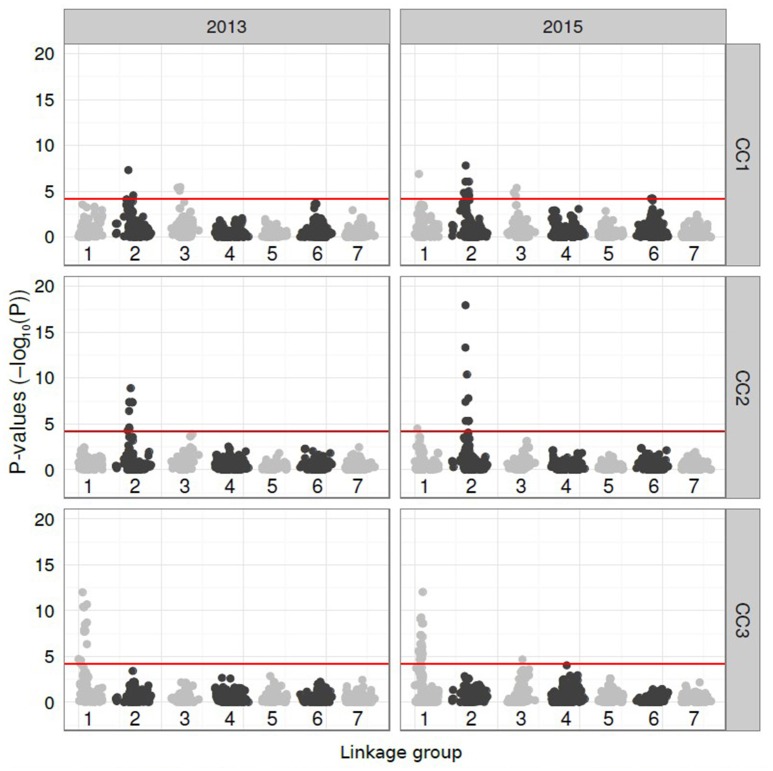
Manhattan plots showing the P-values (minus log10-transformed, y-axis) of SNP markers located on the seven linkage groups (LGs, x-axis) of perennial ryegrass (Lolium perenne L.) for genetic association with the compatibility components (CC-1 to CC-3) calculated from the 2013 and 2015 pollination data. The significance threshold (P > 4.233) is shown as a horizontal red line on each plot. SNP markers on odd and even LGs are given in light and dark grey, respectively.